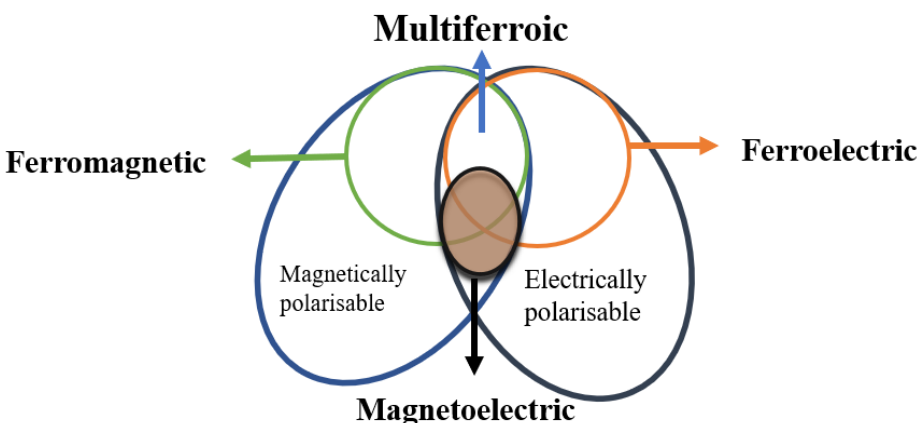
Figure 1. Schematic representation of interrelation between electric and magnetic fields with respect to their polarization.